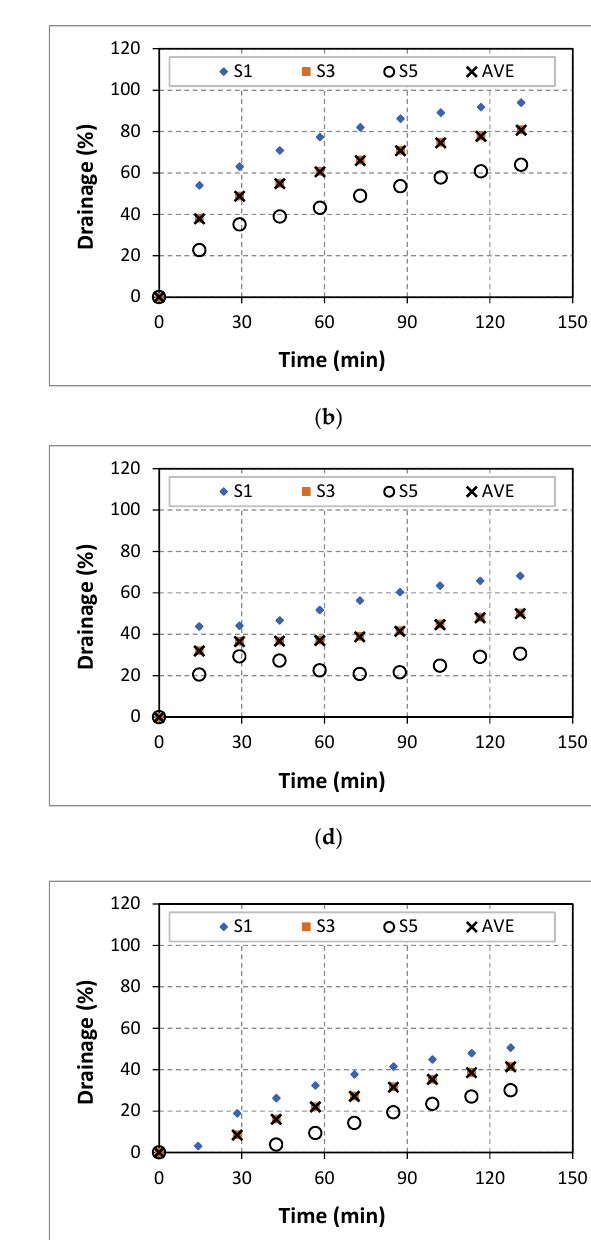
( d ) Figure 6. Shear stress vs. nominal Newtonian shear rate for: ( a ) 5%, ( b ) 9%, ( c ) 14%, and ( d ) 18% CaCl 2 foams. 4.3. Effect of NaCl Concentration on Drainage The drainage experiments were conducted with varying salinity, salt type, and foam quality. The test program involved pressure profile measurements of the foam column using differential pressure transducers installed on the stability cell. Measured pressure profiles are curve fitted using the 2nd degree polynomial function to compute foam drain- age occurring in each segment (a section of stability cell between two consecutive pressure transducers) of the stability cell as a function of time (Figure 7). The cell has nine segments (S1 to S9) formed between ten differential pressure transducers. During the test, the top sections of the stability cell were losing their liquid phase while the bottom sections were accumulating liquid. The initial foam drainage was zero for all the segments. The drainage was measured for 2 h. The drainage process occurring in upper segments (Segments S1, S3, and S5) of the cell is indicated by the increasing trends of the drainage curves. The bottom three segments (Segments S7, S8, and S9) gained a significant amount of liquid